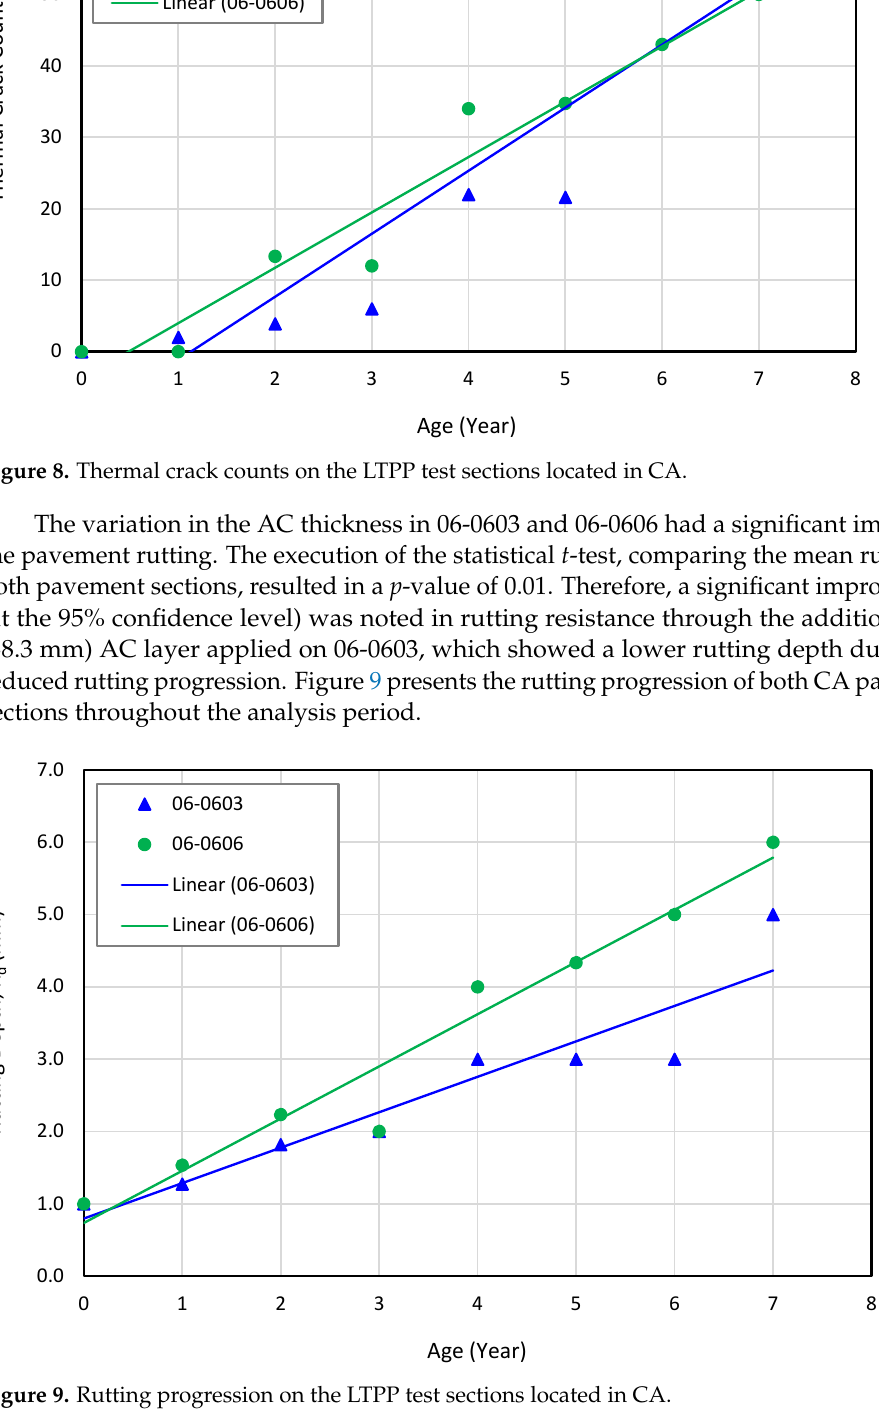
12 of 20 Figure 7. Rutting progression on the LTPP test sections located in NY. 5.2. California (CA) Sections (06-0603 and 06-0606) The performance of the CA sections was analyzed for the period from 1992 to 1999. The CA sections studied are composite pavement sections. These composite sections ex- hibited thermal cracking. They also showed instability rutting, which is caused by high tire–pavement contact shear stresses near the surface. The high stress and radial truck tires result in surface tension, which reduces confinement significantly [39,40]. Limited variation was noted in the transverse (thermal) cracking count by comparing the performances of 06-0603 and 06-0606. These two pavement sections are characterized by an identical climate condition, traffic load, and subgrade type. Transverse (thermal) cracks in non-freezing climate zones are typically classified as surface-initiated reflective cracks, especially in composite pavement sections [41]. Numerous scholars reported the possibility of the propagation of transverse (thermal) top-down cracks through the over- lay surface to match the existing transverse (thermal) cracks in the lower pavement layer